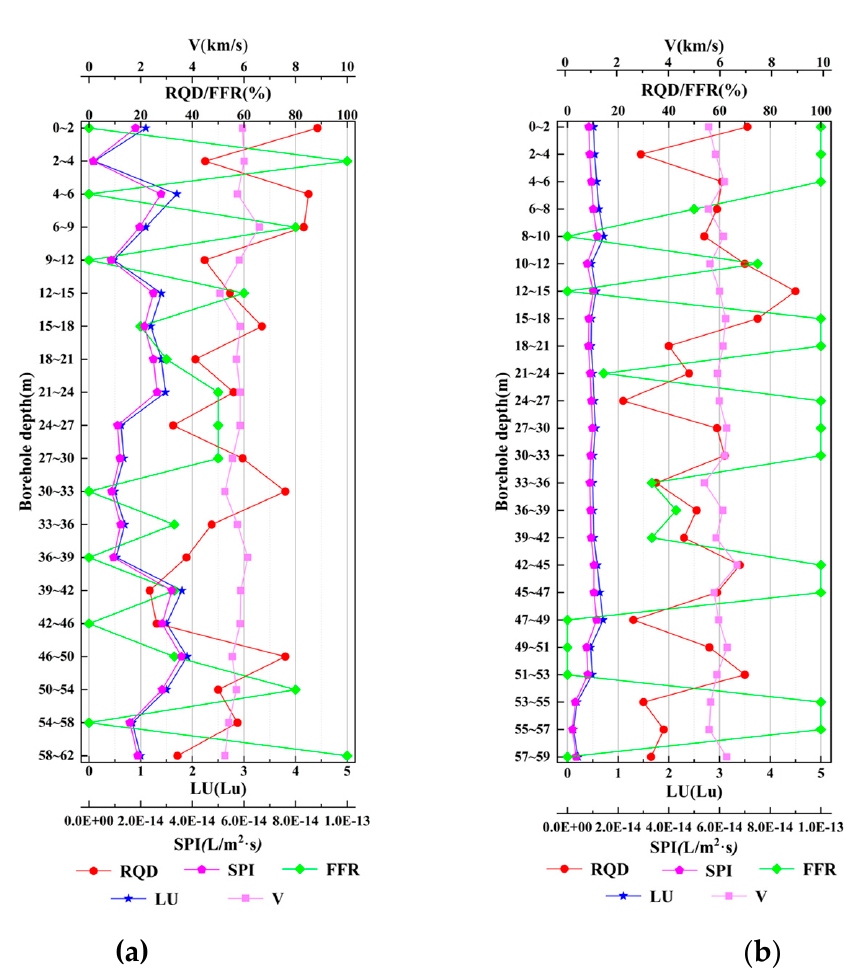
Figure 10. Data of each indicator of a typical borehole: ( a ) Data of each indicator of DJ1-1 and ( b ) data of each indicator of DJ3-1.